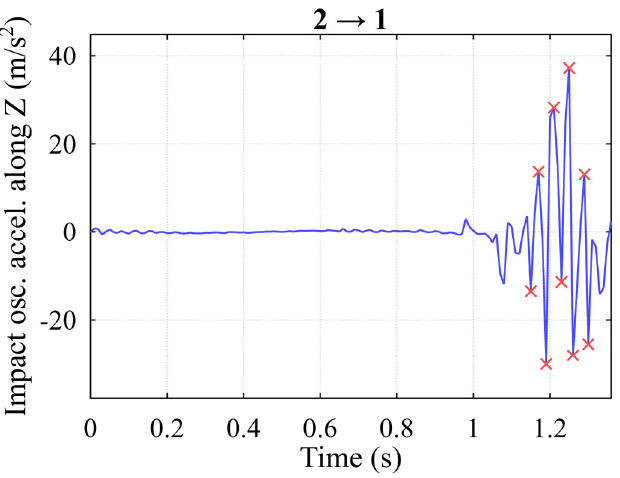
Figure 16. Detected potential impact events (here red crosses indicate the peak values).